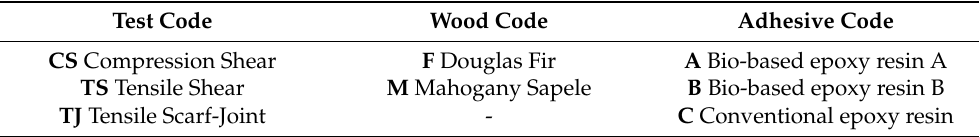
Table 3. Letter meanings of the specimen